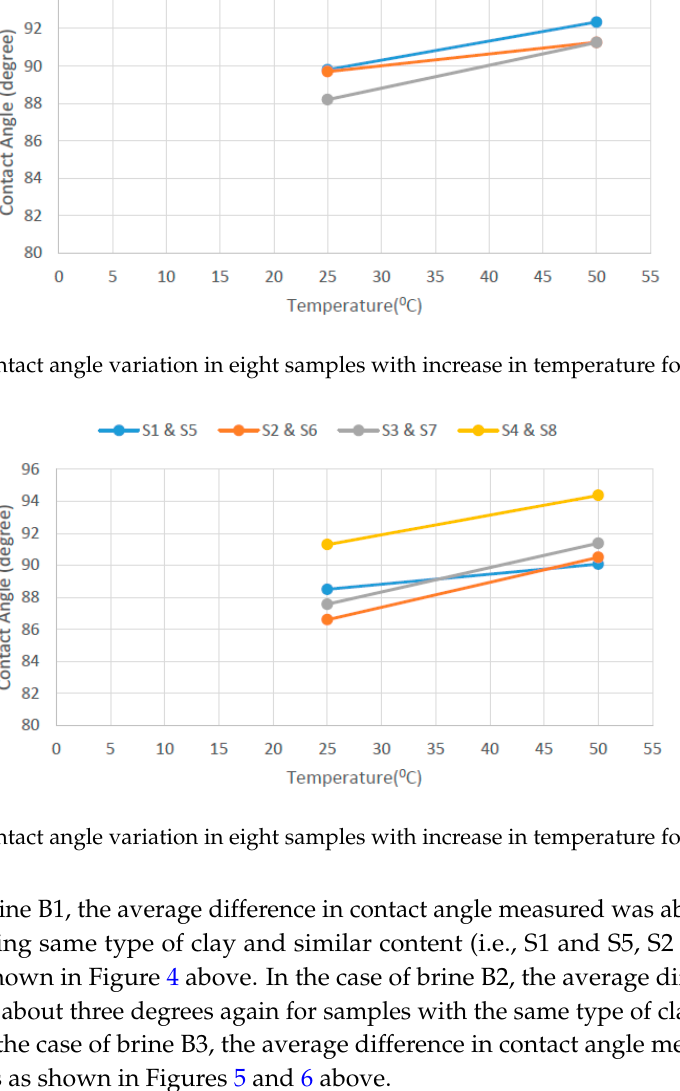
Figure 4. Contact angle variation in eight samples with increase in temperature for brine B1.